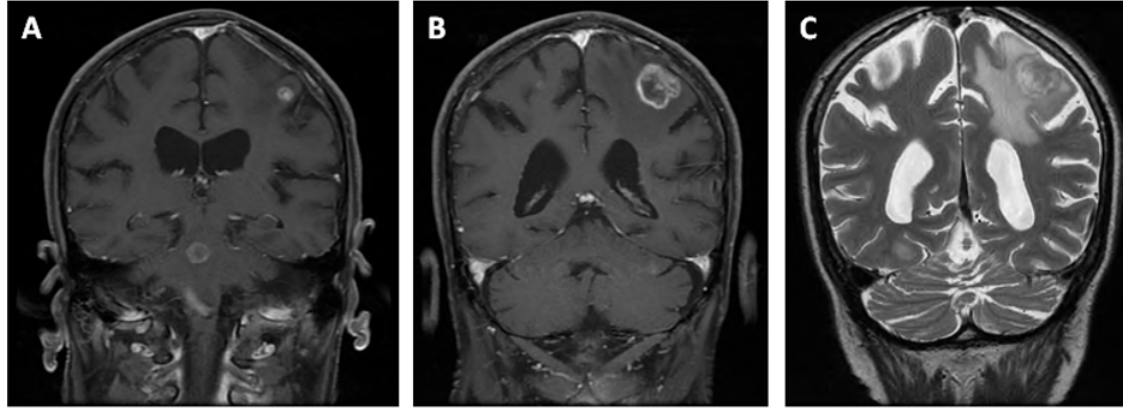
Figure 1. Coronal T1 weighted MRI of the brain reveals multiple ring enhancing lesions in the brain (A,B). A total of sixteen such lesions were identified in all. T2 weighted coronal MRI reveals ring enhancing lesion with surrounding vasogenic edema